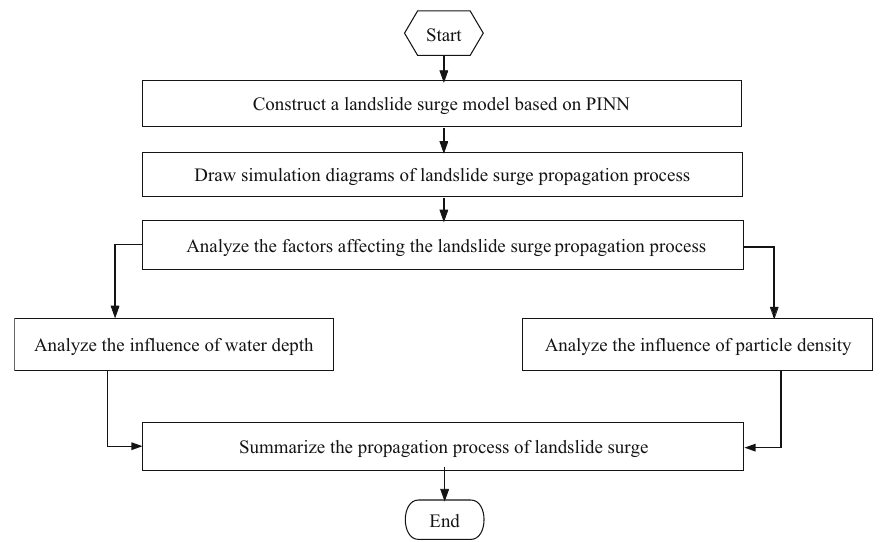
Fig. 3 Flow chart of the method for simulation of the landslide surge propagation process